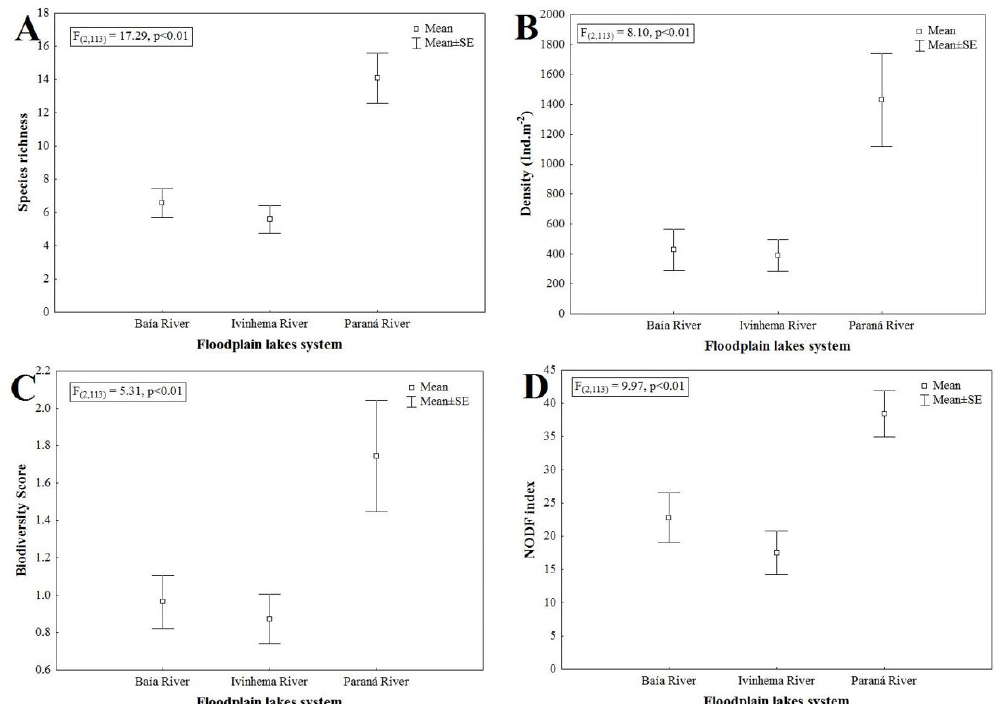
Figure 5. Variations in Chironomidae community in each floodplain lake system according to the mean and standard error (SE) of (A) species richness; (B) density; (C) Biodiversity score; and (D) NODF